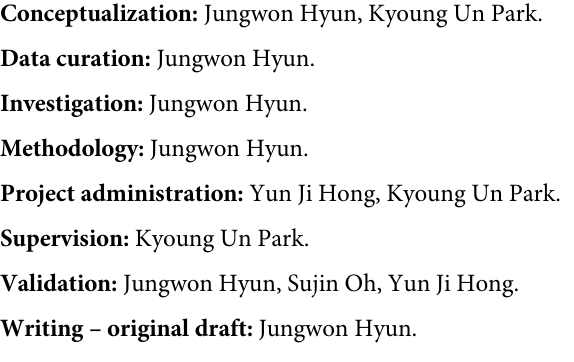
S1 Table. The source of the conventional reference alleles for the 41 blood group genes. S1 Fig. Graphic work flow of this study. Part 1: Conventional reference alleles and coding DNA sequences (CDS) were investigated for 41 genes, including 39 blood group genes involved in 36 blood group antigens, and the GATA1 and KLF1 genes, which are erythrocyte- specific transcription factor genes(12). The human reference genome (hg19) UCSC genomic transcripts (corresponding to the splicing pattern of the conventional CDS) for these 41 genes were also investigated using the UCSC genome browser(15). The CDS of the conventional ref- erence alleles and the human reference genomes for each gene were aligned, and the Clustal Omega website was used to identify nucleotide changes(16).We then analyzed the differences between hg19 and conventional reference cDNA and determined the blood group alleles of hg19. Part 2: After importing the 250 Korean WGS data (BAM) using CLC genomic Work- bench 11.0 (Qiagen, Aarhus, Denmark)(17), the data were realigned to hg19, and variant anal- ysis was performed on the coding regions of the 41 blood group-related genes. The alleles of each blood group were predicted by analyzing the variants for each gene and comparing them with the hg19 genotype. Abbreviations: CDS, coding DNA sequences; WGS, whole-genome